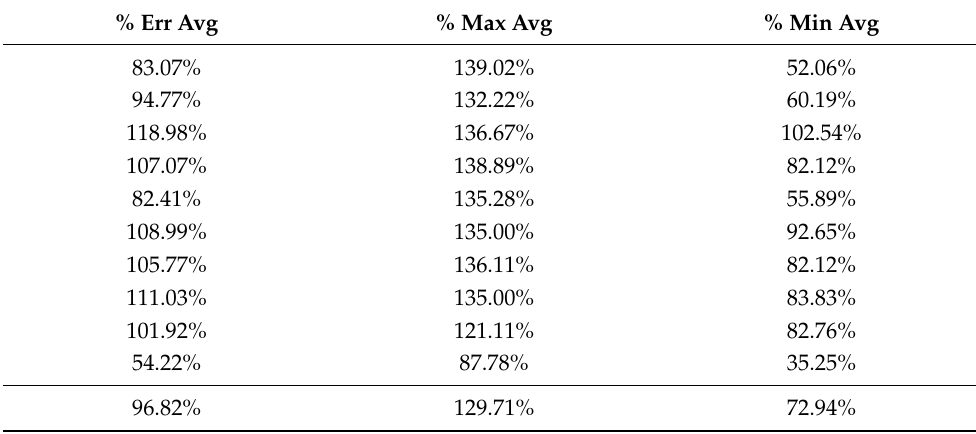
Table A27. Set 1, trials 11–20 data (all 0.5 PR values).